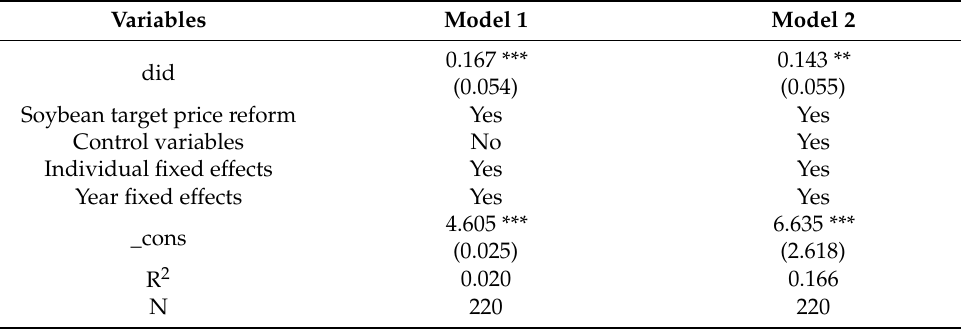
Table 7. Regression results after eliminating interference